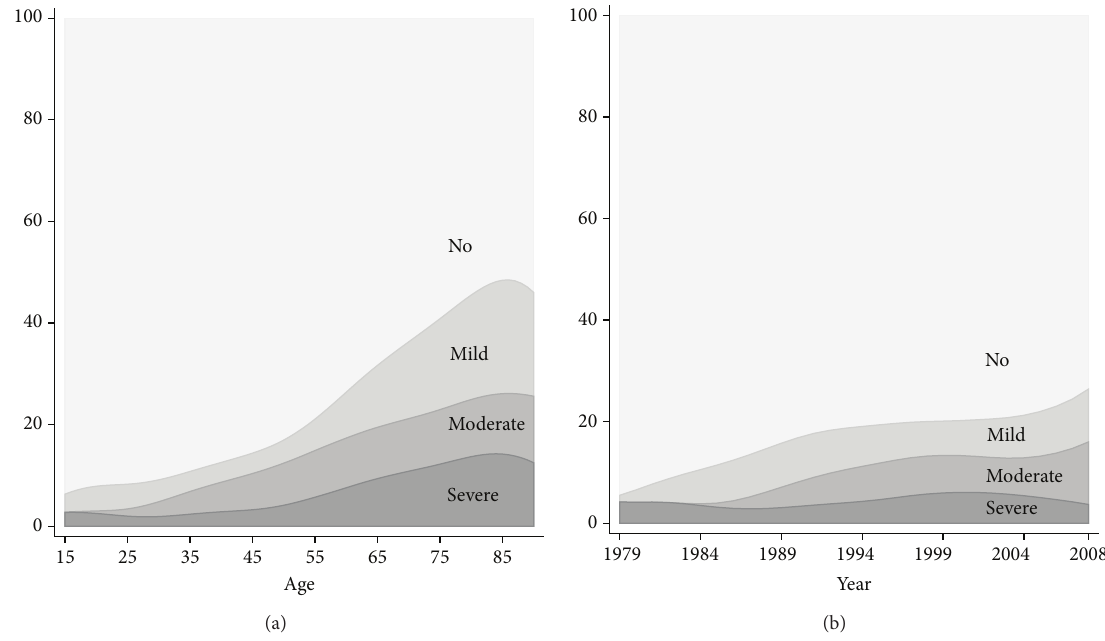
Figure 2: The prevalence of comorbidity as a percentage by age (a) and calendar year of diagnosis (b) in adult bone sarcoma patients treated at the Sarcoma Centre of Aarhus University Hospital in the period from 1979 to 2008 ( 𝑁 = 453 ).